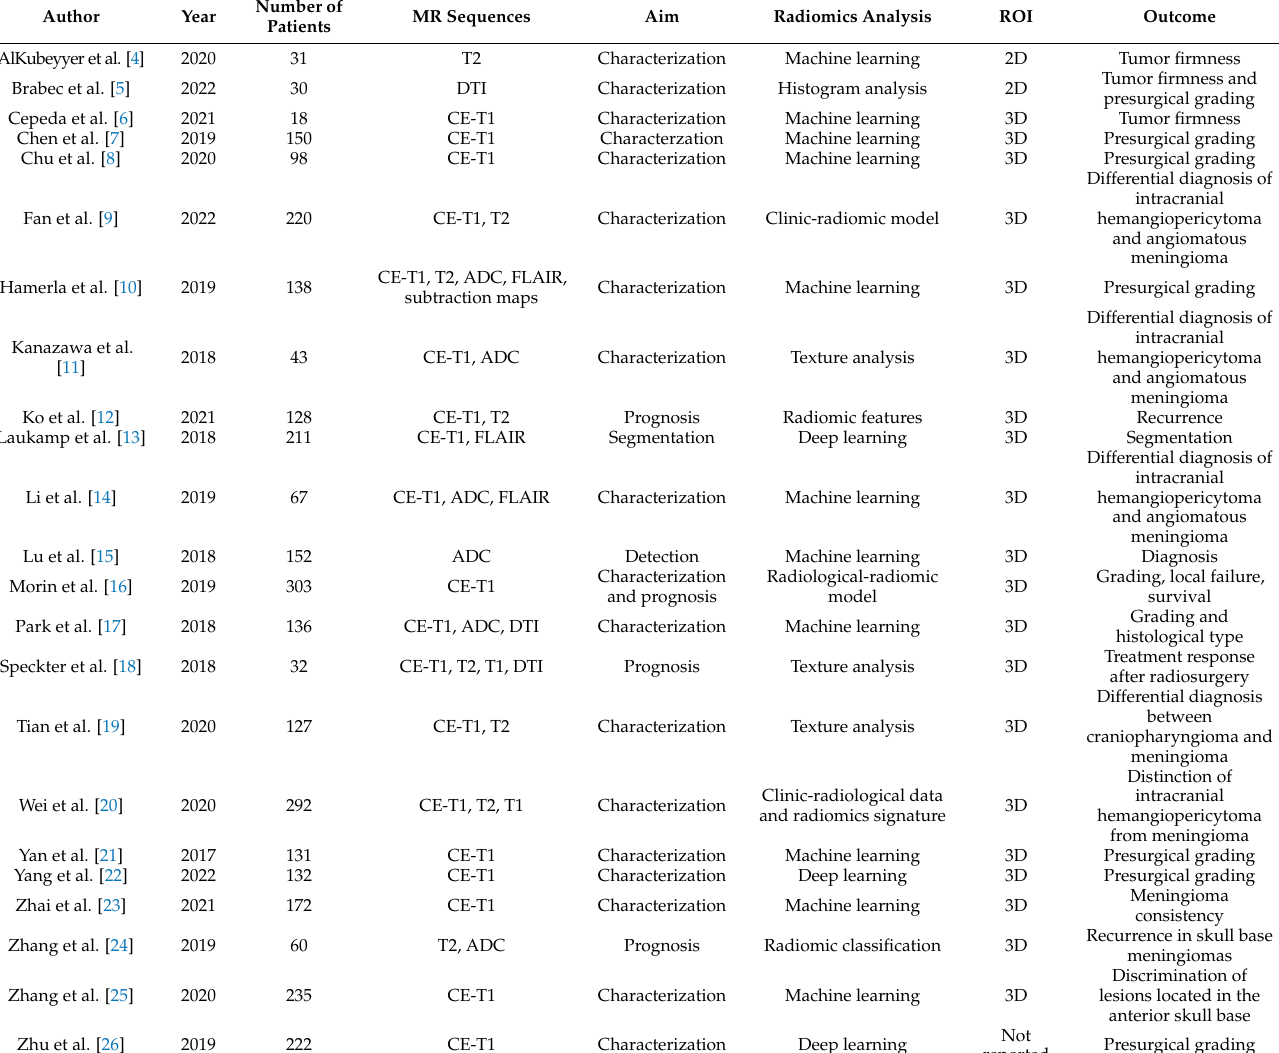
Table 1. Overview of meningioma radiomics